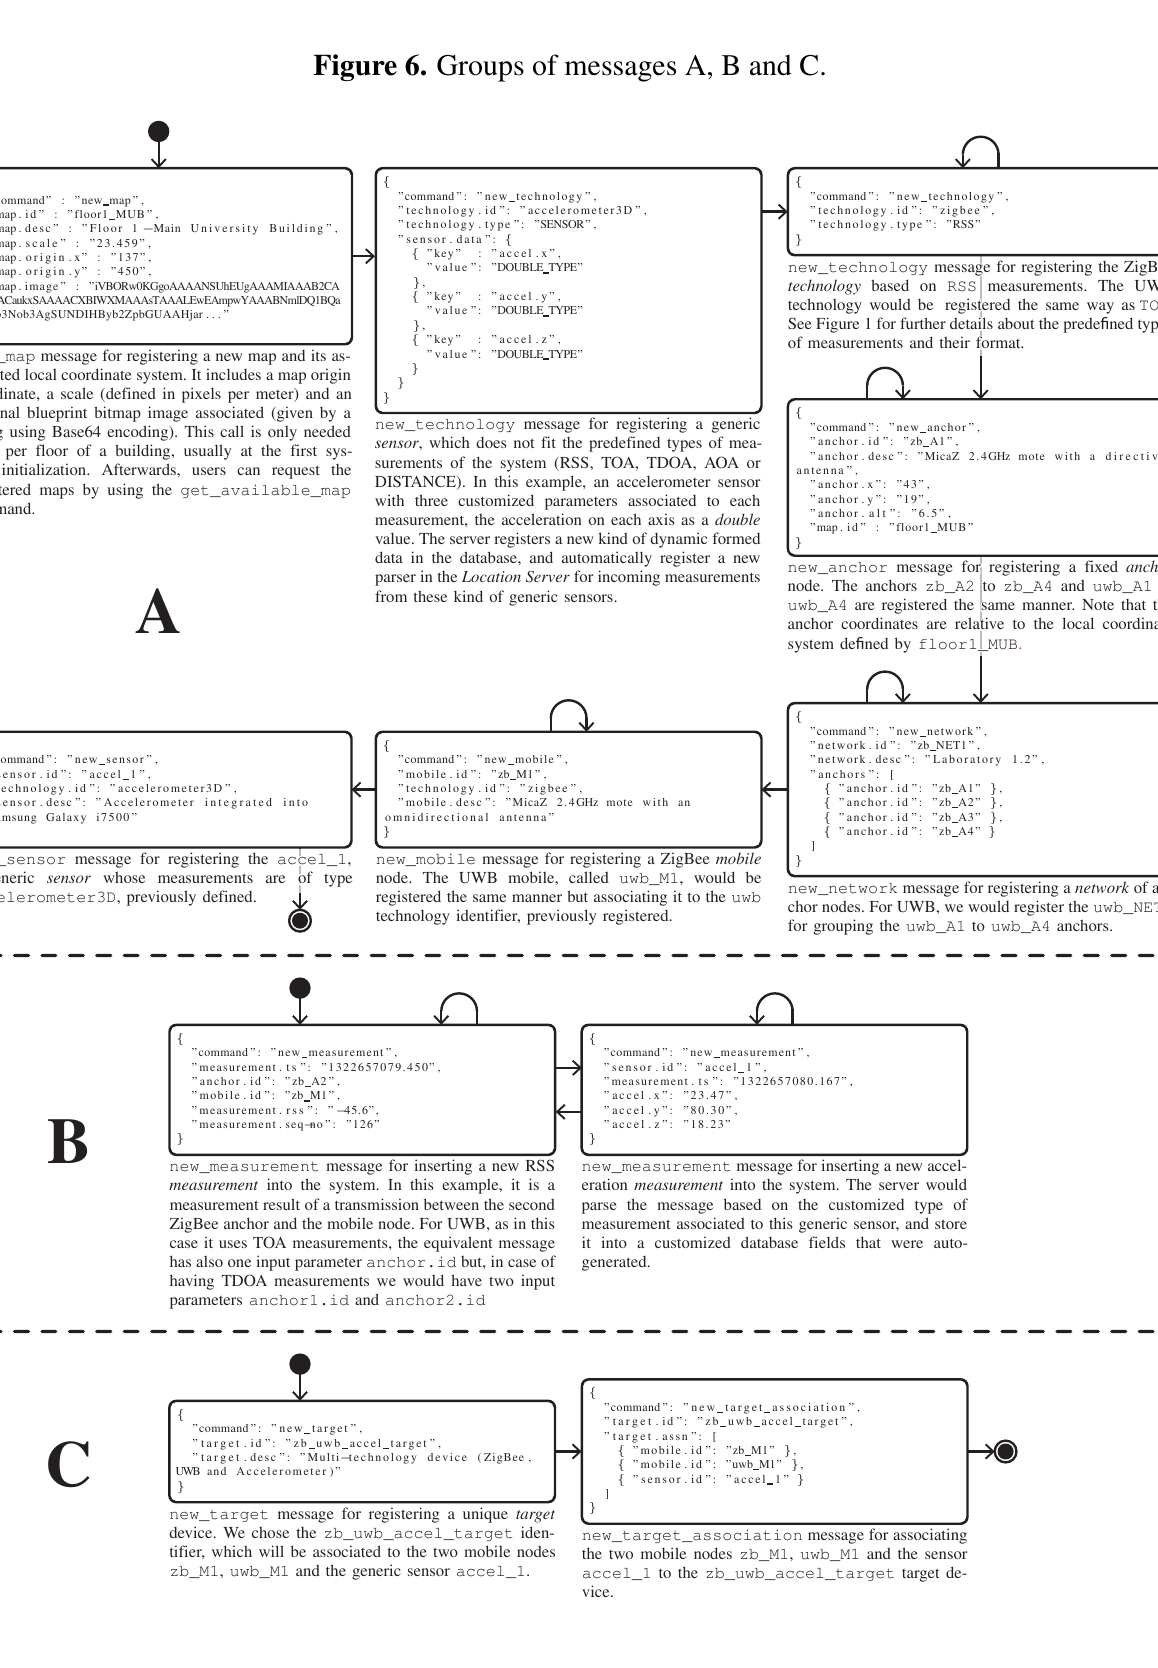
Figure 6. Groups of messages A, B and